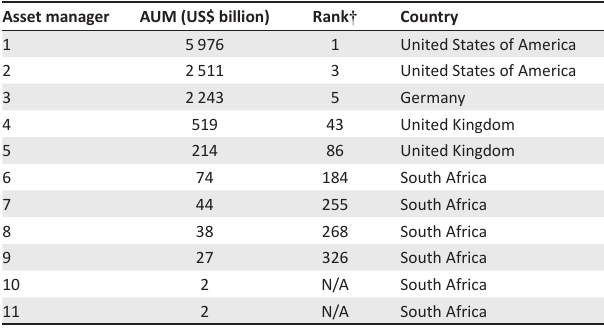
TABLE 3: Details on the selected asset managers. Asset